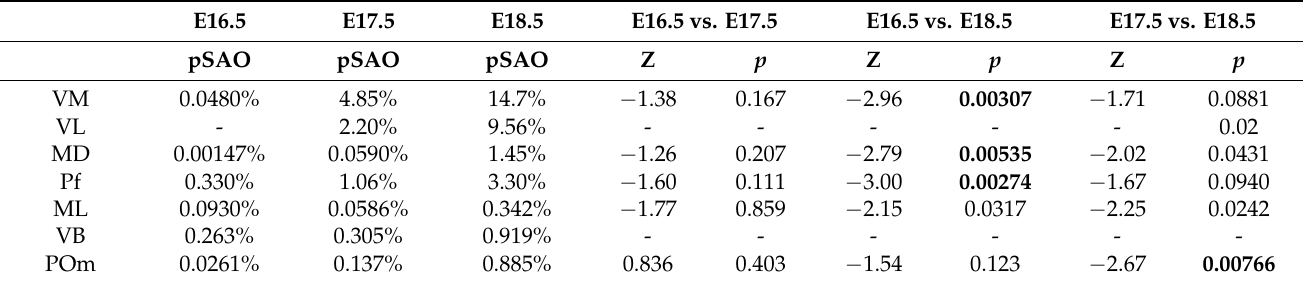
Table 5. pSAO values (in %) of the investigated thalamic nuclei and the Z- and p -values of the differences between the age groups of each of these nuclei. Šid á k-corrected p -values of 0.0127 were used for all nuclei, except VL for which a Šid á k-corrected p -value of 0.017 was chosen. Significant differences are indicated in bold letters. For VB there was no post hoc test since the Kruskal–Wallis analyses showed no significant difference.